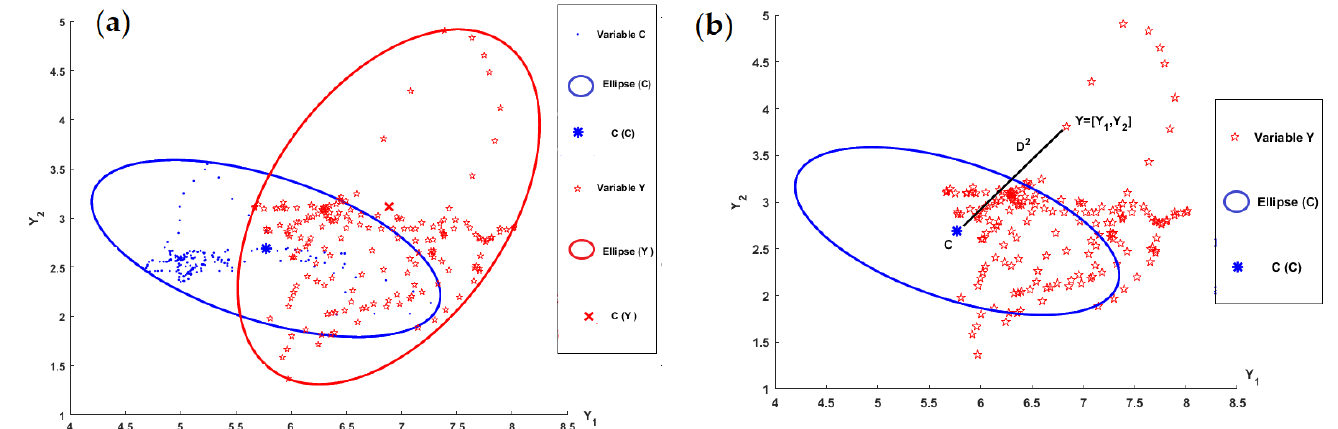
Figure 4. Near stable ( a ) Distributions of the near-stable multivariate variable C and the multivariate variable Y . ( b ) Graphical representation of D 2 calculation between the observations of the multivariate variable Y and ( C , S c ) of the multivariate variable C